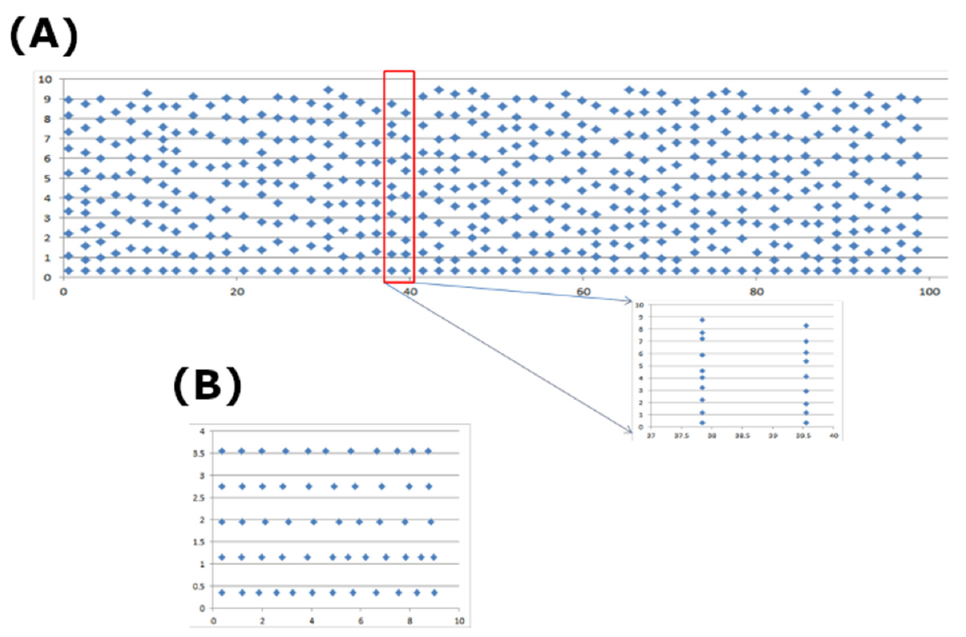
Figure 2. The placement of calcium release sites ( A ) at one Z-depth, and ( B ) at one Z-disc. The inset in ( A ) shows the CRUs on two T-tubules at two adjacent Z-discs. The distribution of inter-CRU distance is derived based on the experimental data.